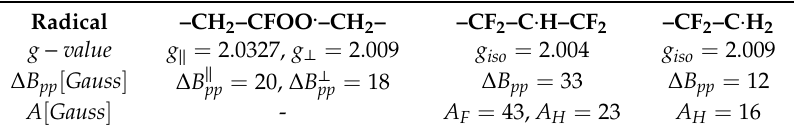
Table 1. g-values of common radiation-induced radical species in